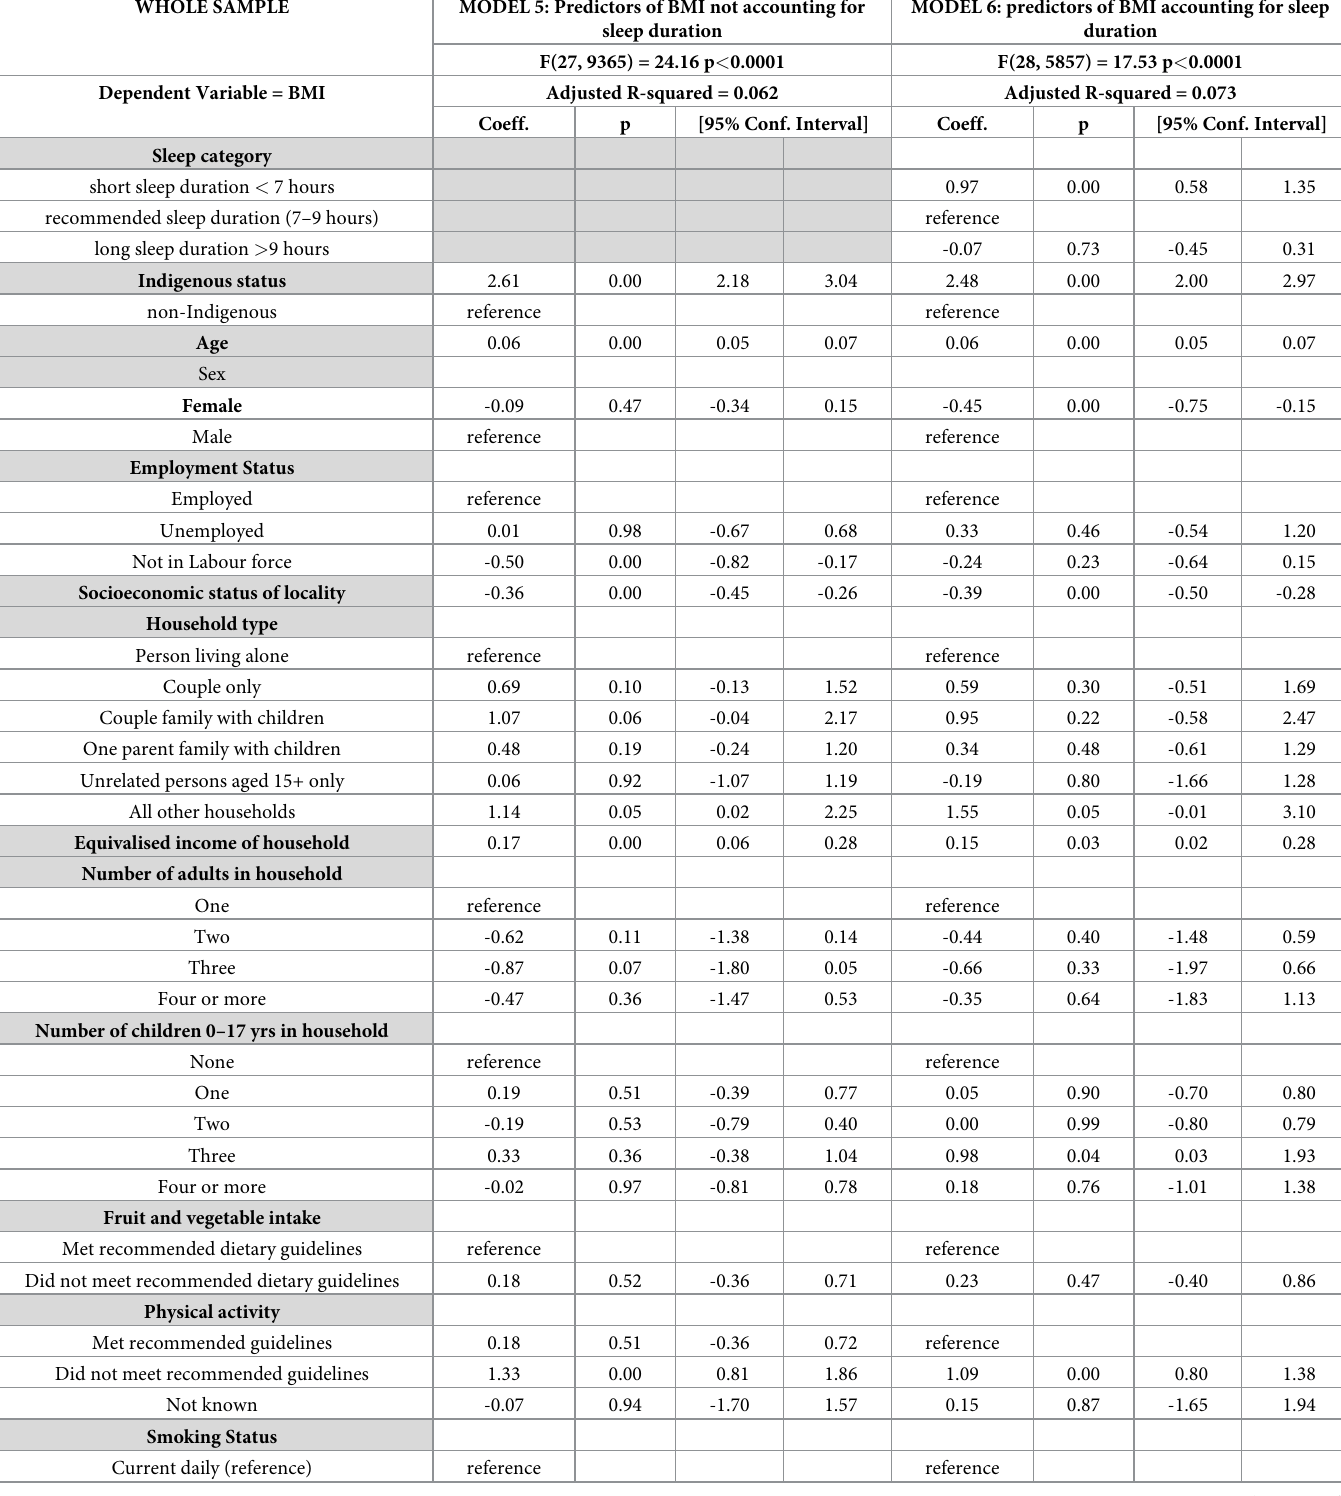
Table 4. Predictors of BMI accounting for indigenous status. WHOLE